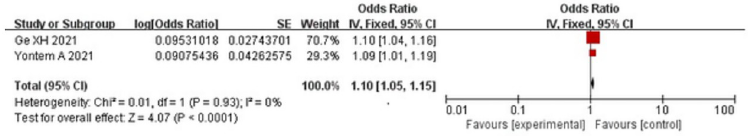
Fig 9. Forest plot for PICU LOS analysis. We conducted meta-analysis for 2 studies using a random effects model. We used ORs and 95% CIs to represent the results.